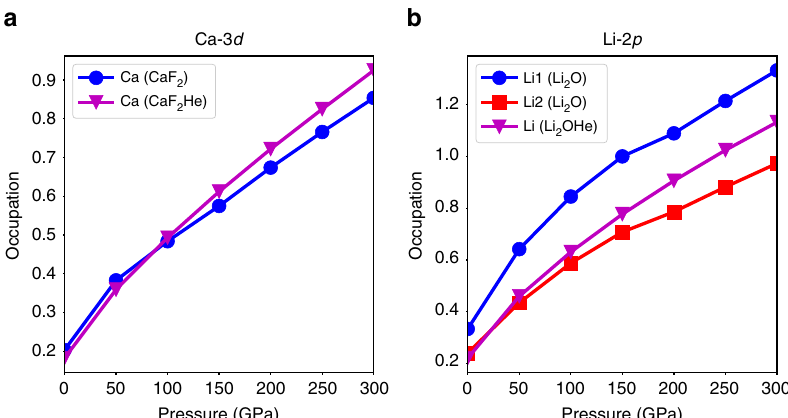
Fig. 7 Orbital occupations of Ca-3 d and Li-2 p orbitals in A-B and A-BHe compounds. a The d orbital occupation of Ca ions in both CaF 2 and CaF 2 He. b The p orbital occupation of Li ions in both Li 2 O and Li 2 OHe. Li 1 and Li 2 represent Li atoms at two inequivalent sites in